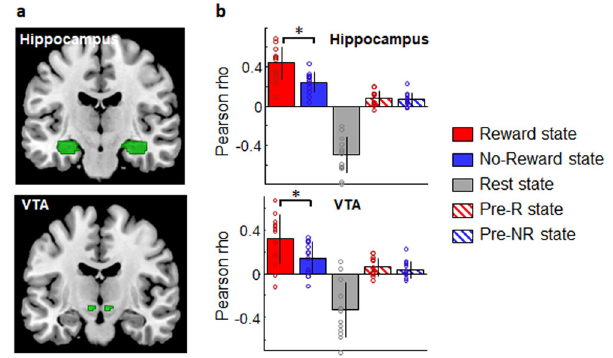
Fig. 5 Reward-related reactivation in hippocampus and ventral tegmental area (VTA) during sleep ( N = 13). a Anatomical masks used as regions of interest (in green). b Mean correlation values for all participants between the time courses of the regions of interest and the different brain states. Asterisks indicate p < 0.002 for the hippocampus and p < 0.02 for the VTA for the Reward vs. No-Reward comparison, for two-sided post-hoc t tests. Error bars represent SD (Standard Deviation); dots represent individual data. Repeated measures ANOVA with post-hoc test (planned comparison). Source data are provided as a Source Data fi le.